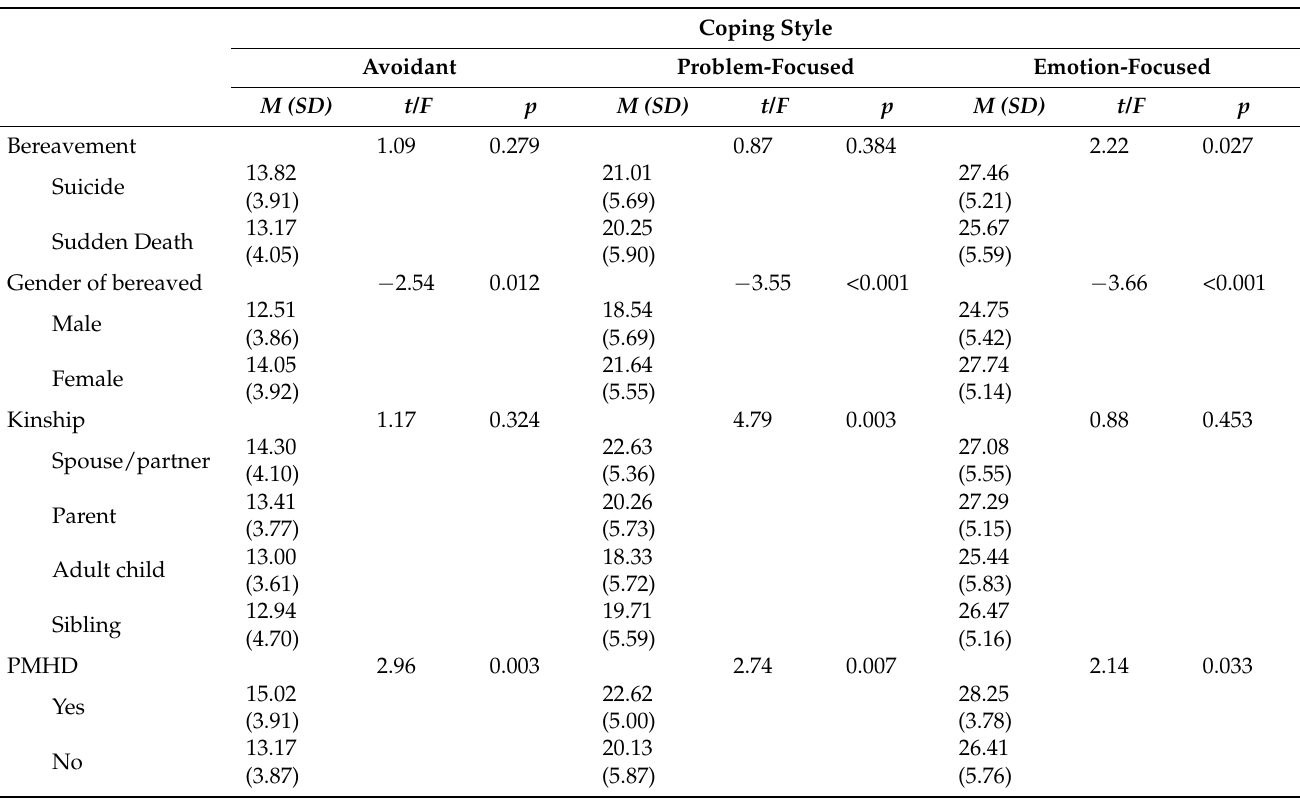
Table 2. Group differences by coping